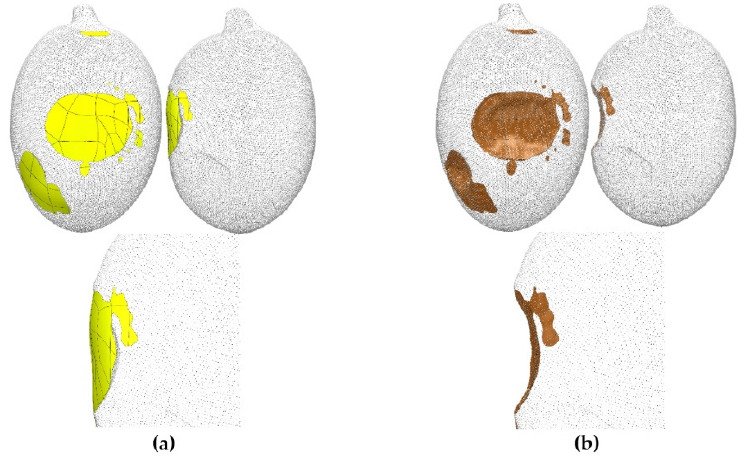
Figure 12. Diseased areas: ( a ) 3D outer surface, and ( b ) 3D inner surface.